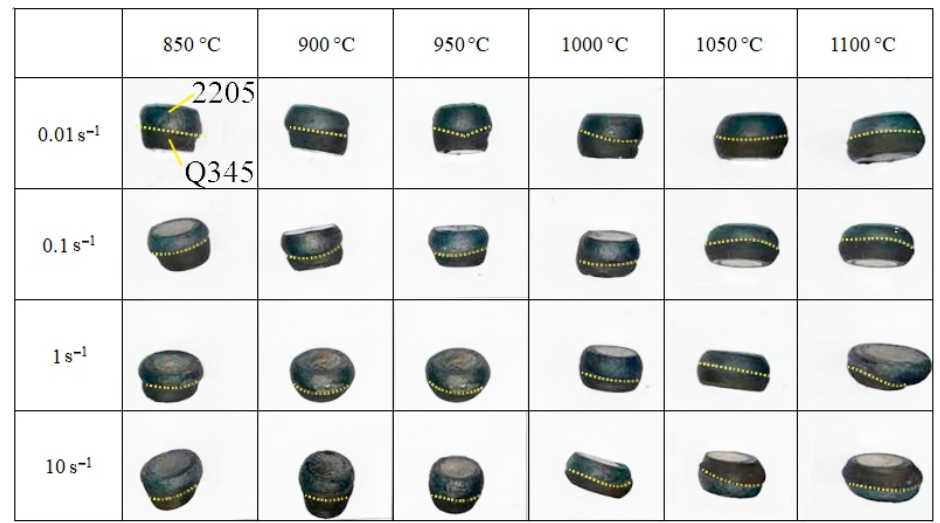
Figure 3. 2205/Q345 thermal compression composite macro sample.